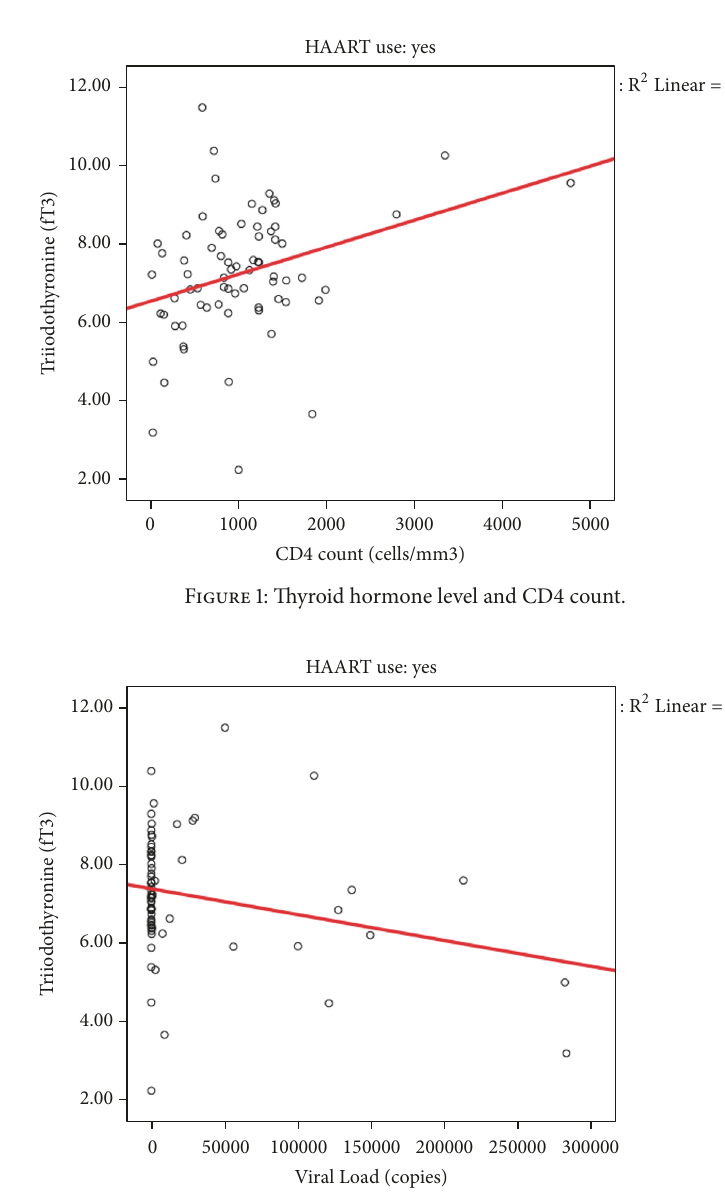
Figure 2: Thyroid hormone level and viral